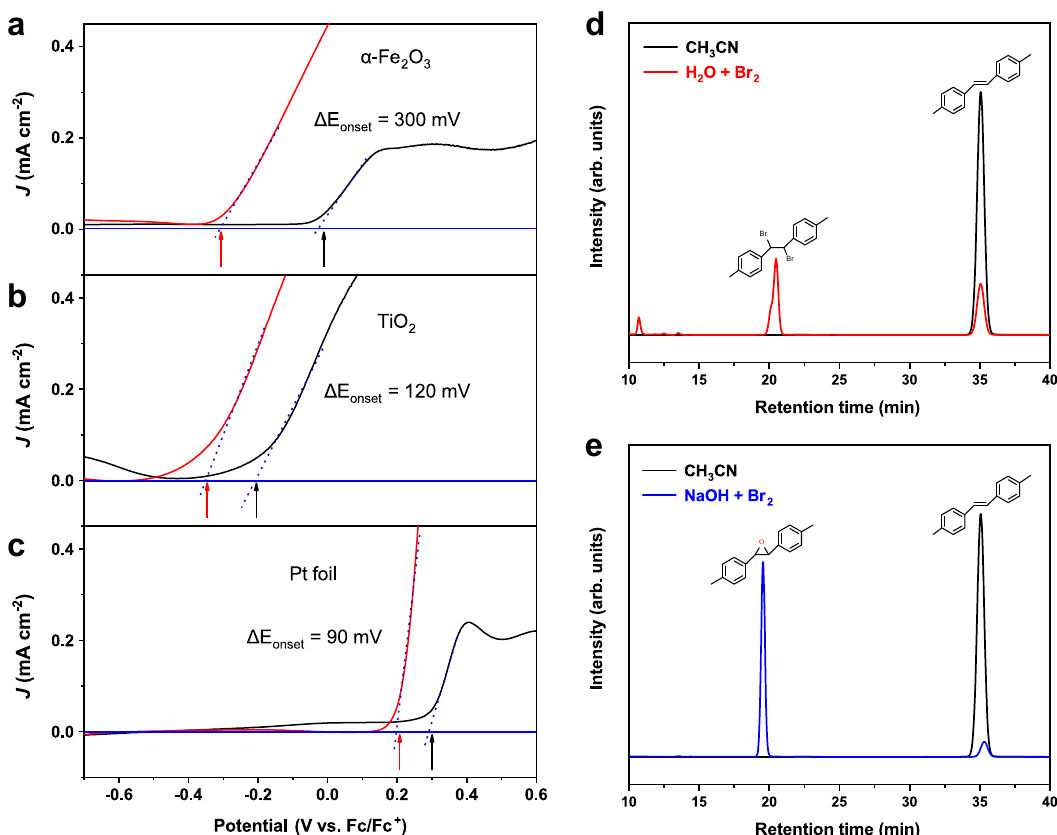
Fig. 3 | J – V scan and the product distribution. Comparison on J – V scan of ( a ) α - Fe 2 O 3 , ( b ) TiO 2 under AM 1.5G illumination, and ( c ) Pt foil electrode measured in 100mM TBABF 4 (black lines) and TBABr (red lines) solution (CH 3 CN with 5% H 2 O)